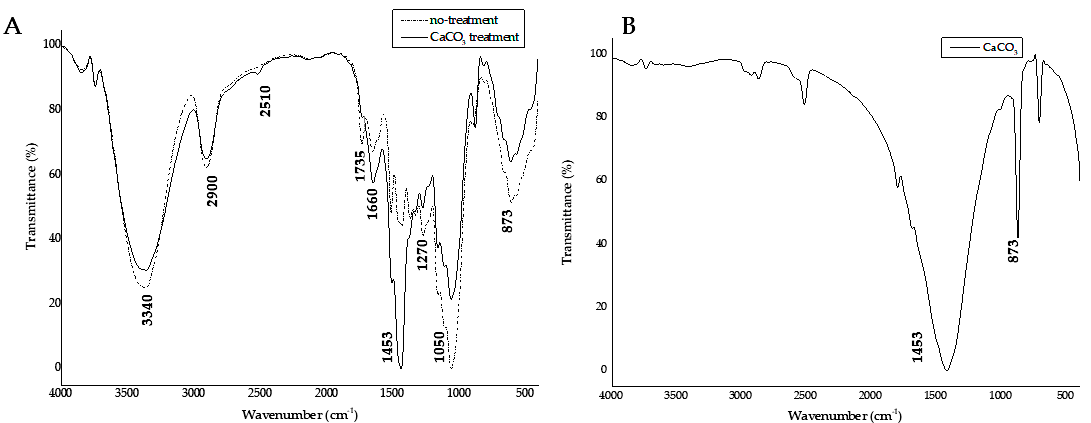
Figure 4. FTIR analysis, ( A ) untreated and treated wood samples and ( B ) CaCO 3 standard.